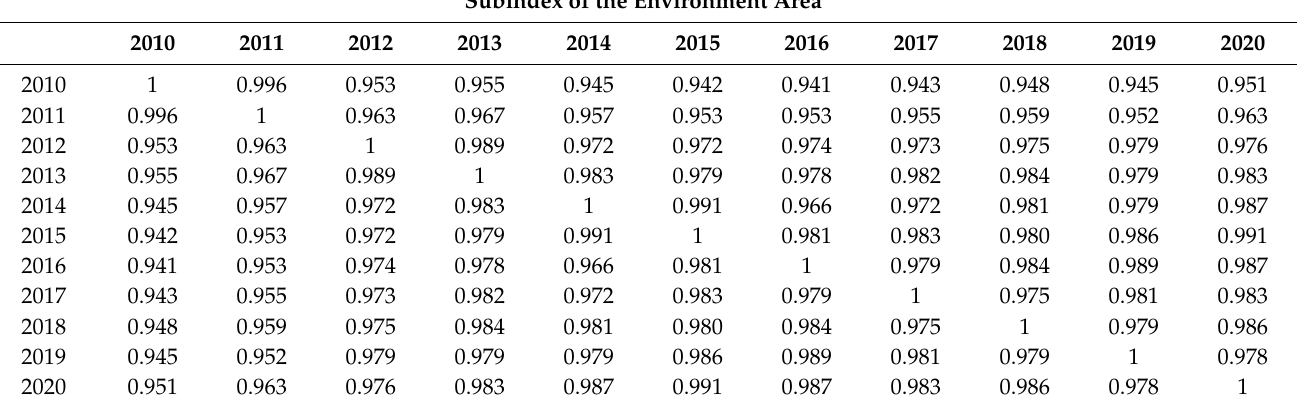
Table 7. Pearson correlation between values for a given EI in 2010–2020 (Subindex of the environment area).